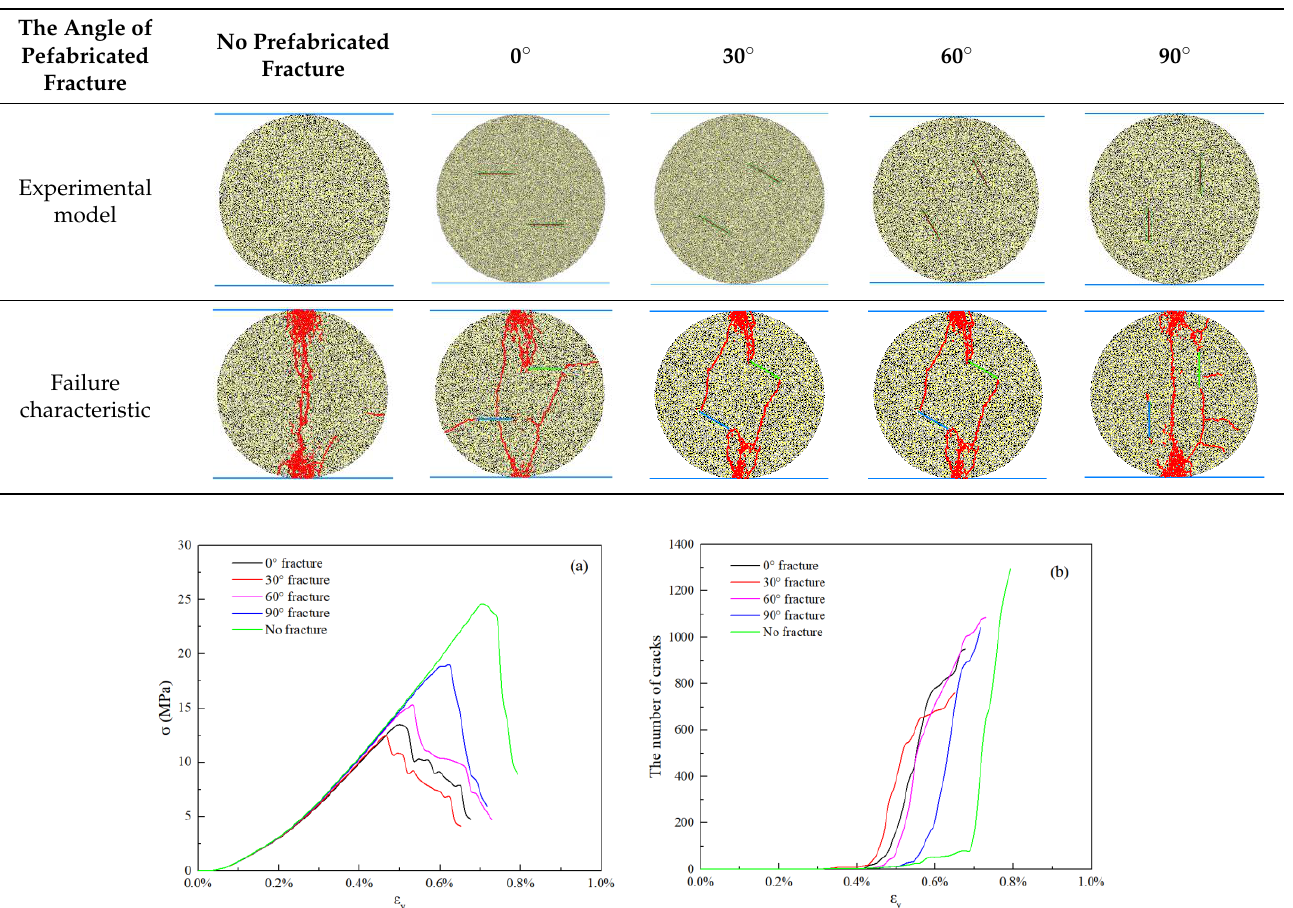
Table 2. The failure characteristics of granite by Brazilian splitting simulation.